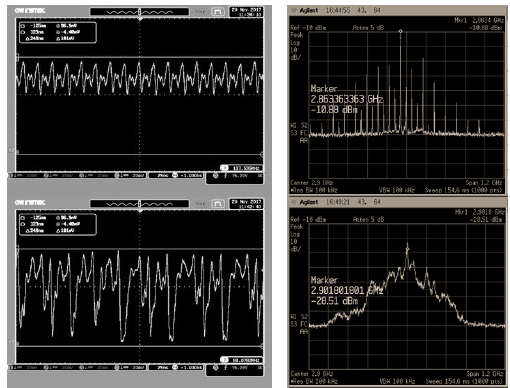
Fig. 10. The cascade of bifurcations of doubling the envelope modulation period